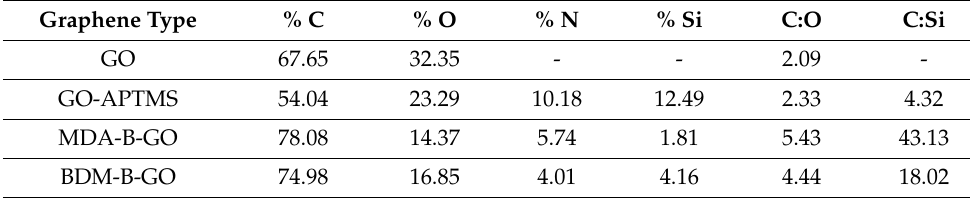
Table 2. XPS data of GO, GO-APTMS, MDA-B-GO, and BDM-B-GO.